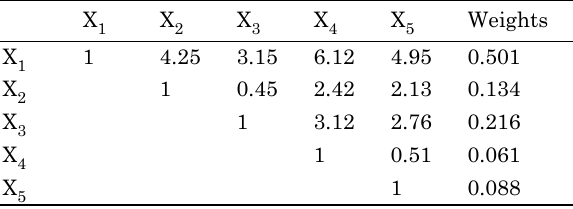
Table 4. Pairwise comparison judgment matrix of indices and criteria influencing the choice of exterior walls appraisement to reconstruct iran earthquake areas (ahar heris Varzeqan)